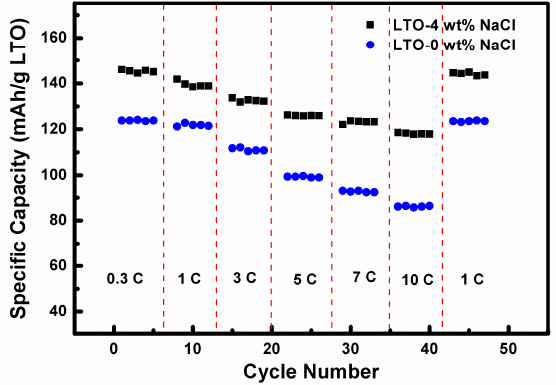
Figure 3. Specific initial discharge capacities of LTO with various NaCl additions at 0.3 C-rate.